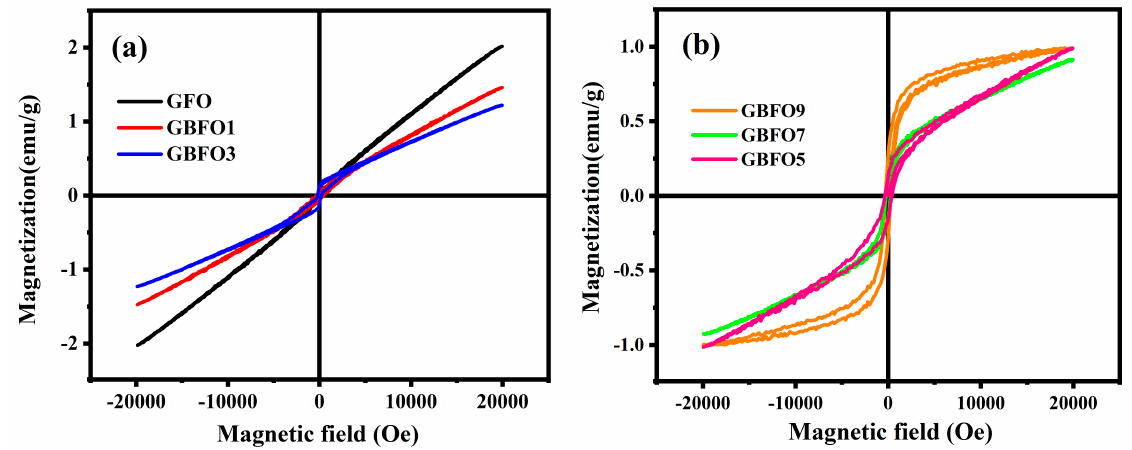
Figure 4. Room temperature magnetic hysteresis loops of ( a ) GFO, GBFO1 and GBFO3 samples; ( b ) GBFO5, GBFO7 and GBFO9 samples.